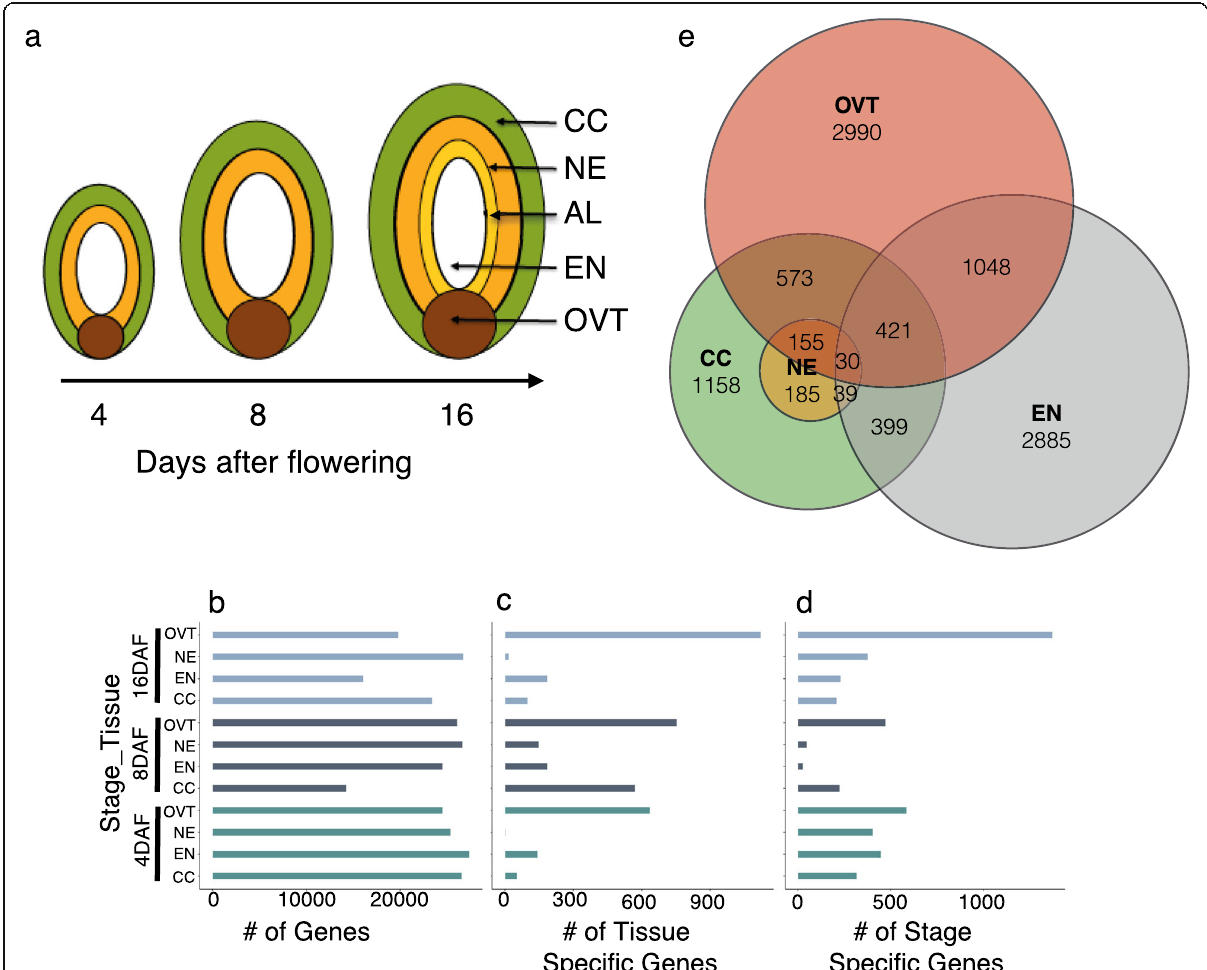
Fig. 1 DEGs in different tissues and at developmental stages of the rice grain. a Graphic illustration of tissues and stages in developing rice grains collected in this study. b Total number of genes expressed at each developmental stage and in different tissues. Number of DEGs expressed in the specific rice grain tissues (c) or at the different stages of rice grain development (d) are indicated. e Venn-diagram showing the number of AL-specific DEGs compared pair-wise to CC, EN, NE and OVT DEGs at 16-DAF, respectively. NE: Nucellar Epidermis; CC: Cross Cells; OVT: Ovular Vascular Trace; EN: Endosperm; AL: Aleurone